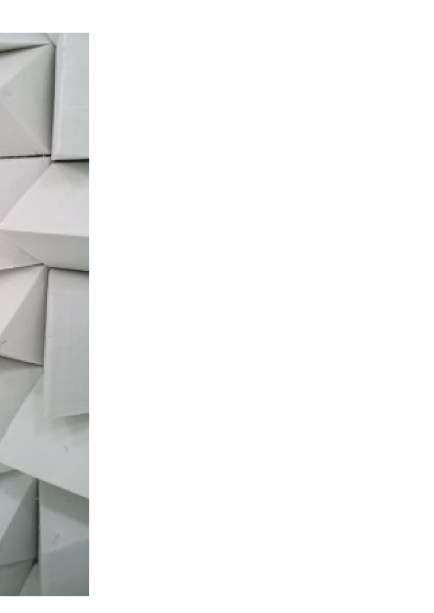
Figure 4. Mask S on the Head and Torso Simulator in the anechoic chamber of Politecnico di